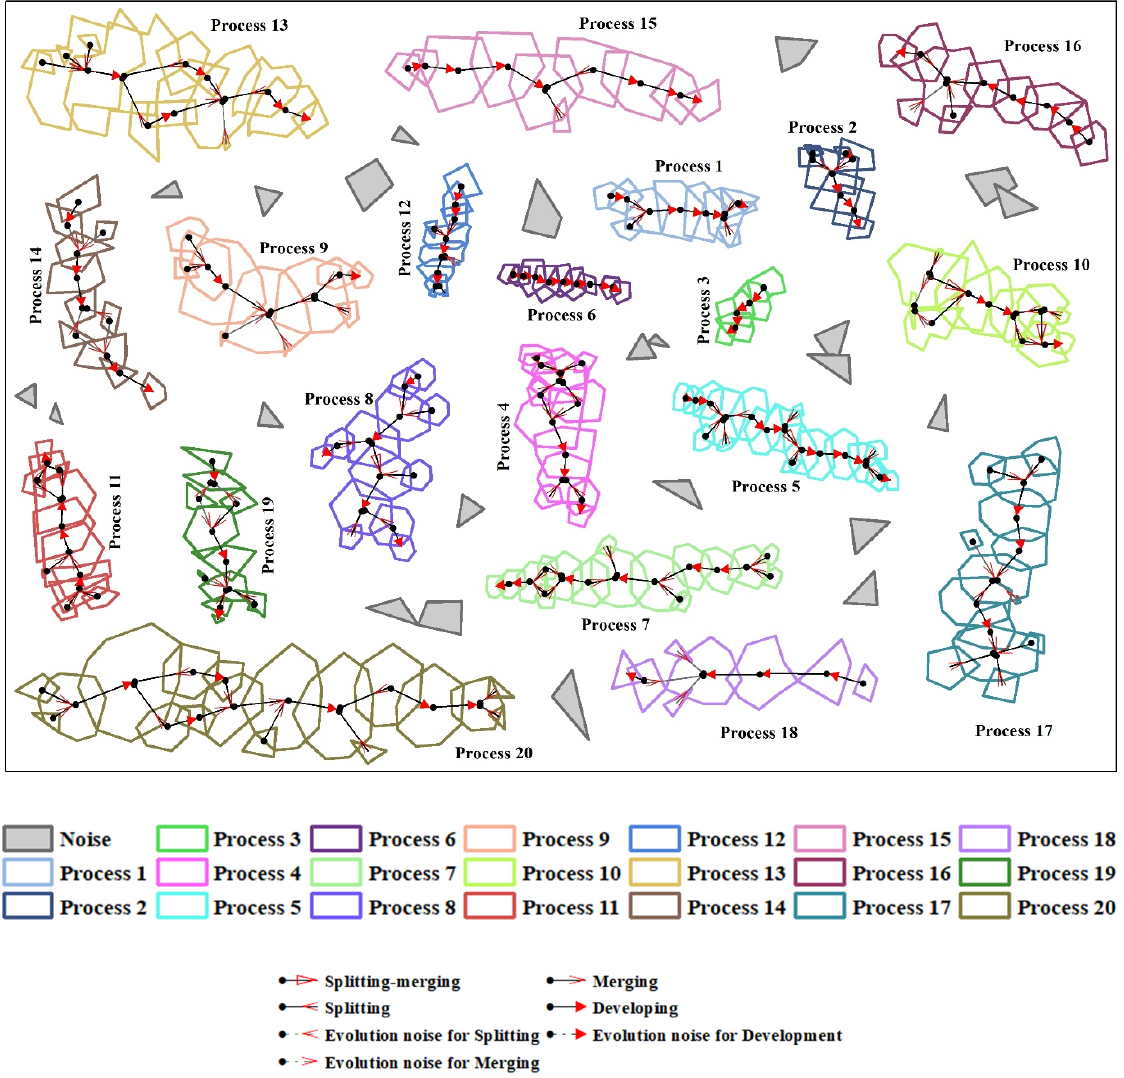
Figure 5. Simulated datasets of process objects and noises.